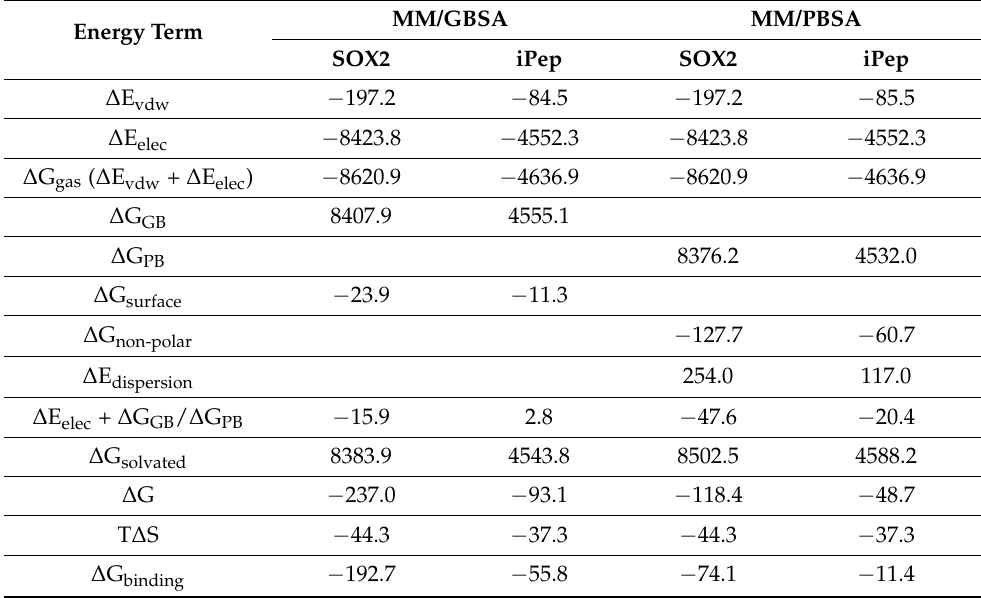
Table 1. Predicted average free energies of binding of SOX2 and iPep to Figure 4. enhancer in the presence of OCT4. Energies are reported in